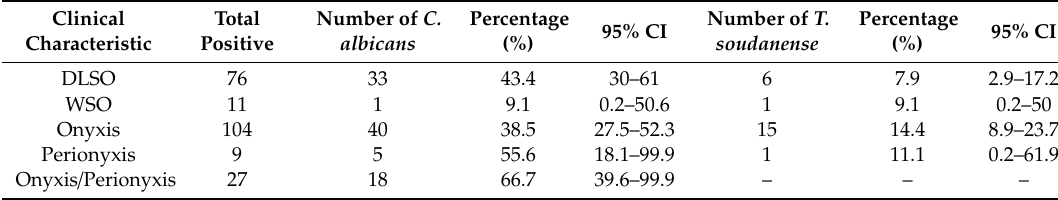
Table 7. Variation of Onychomycosis with Candida albicans and Trichophyton soudanense according to the clinical aspects of the